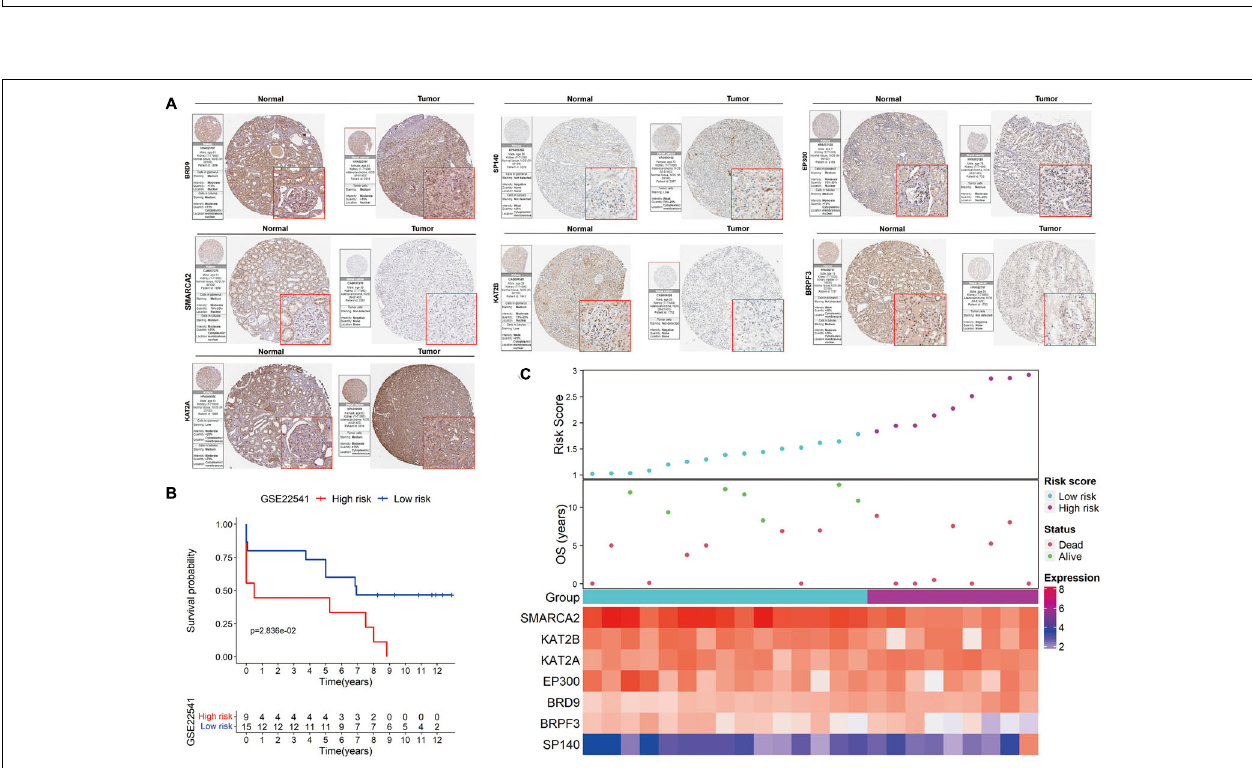
FIGURE 7 | Validation of the signature on HPA and GEO. (A) The expression of the signature genes between KIRC and normal tissues at the translational level. (B) Kaplan-Meier survival analysis for low − and high-risk patients. (C) The distribution of risk scores, OS and the final status and the expression patterns of the signature